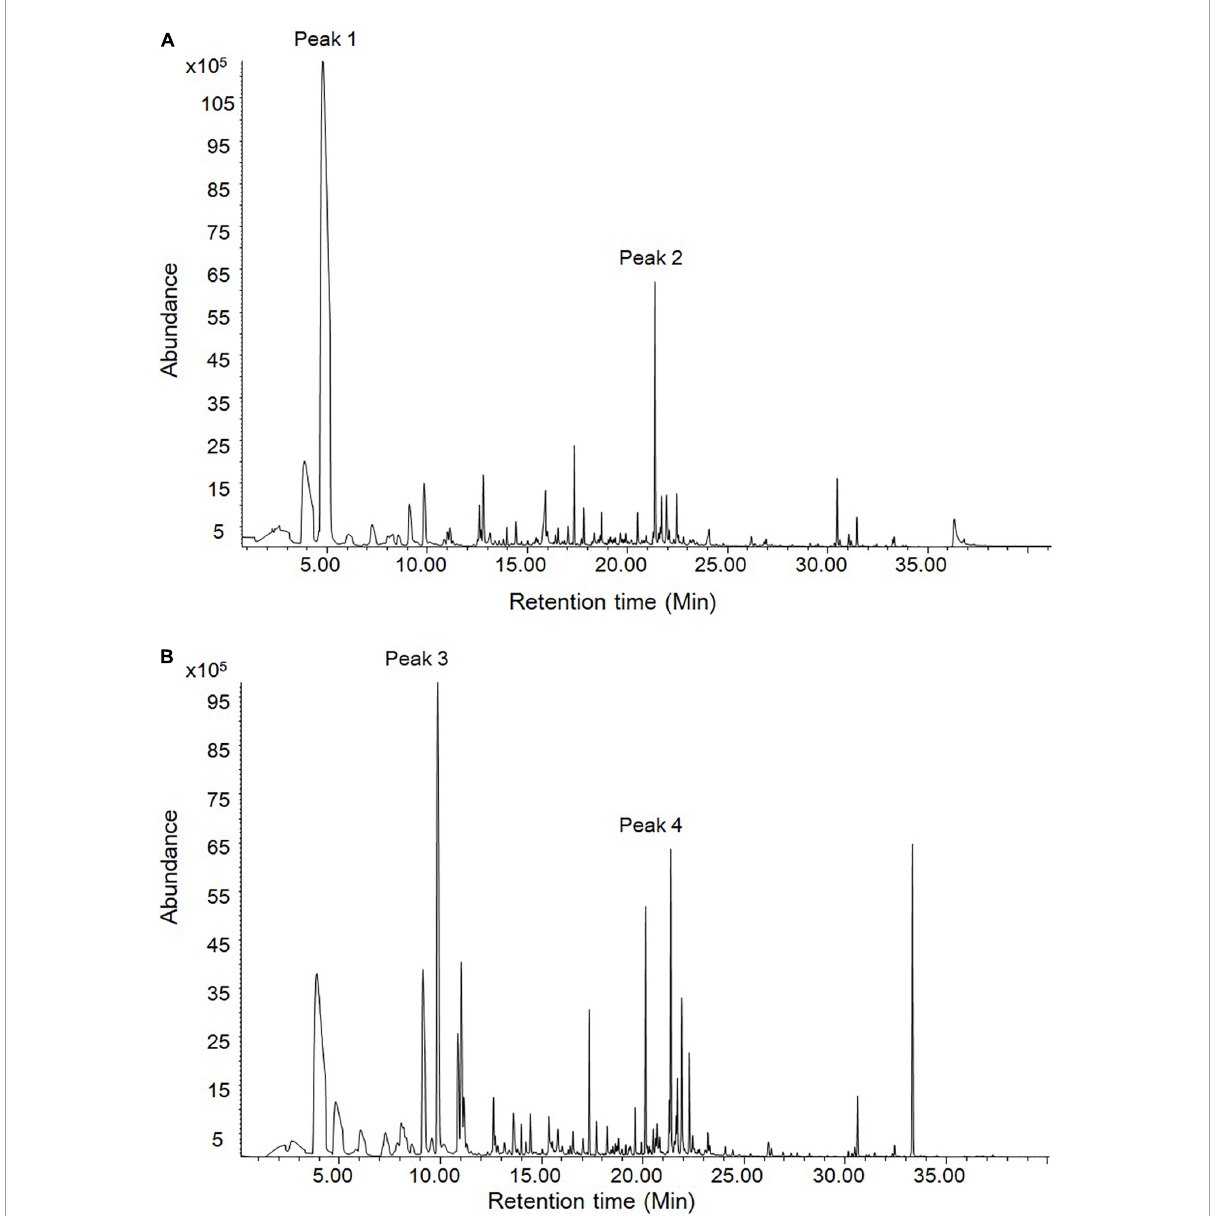
FIGURE2 The volatile compounds in leaves and stems of D. officinale through headspace SPME-GC/MS analysis. (A) The leave volatiles were detected. (B) The stem volatiles were detected. According to RI and mass spectra, peak 2 and peak 4 were qualitatively identified as